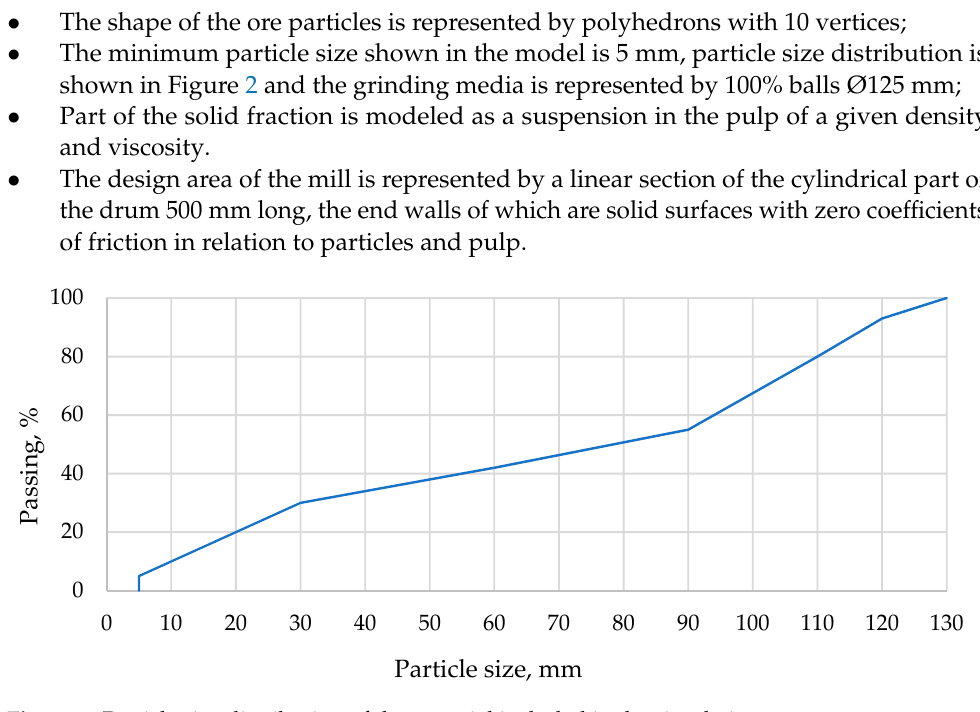
Figure 2. Particle size distribution of the material included in the simulations.